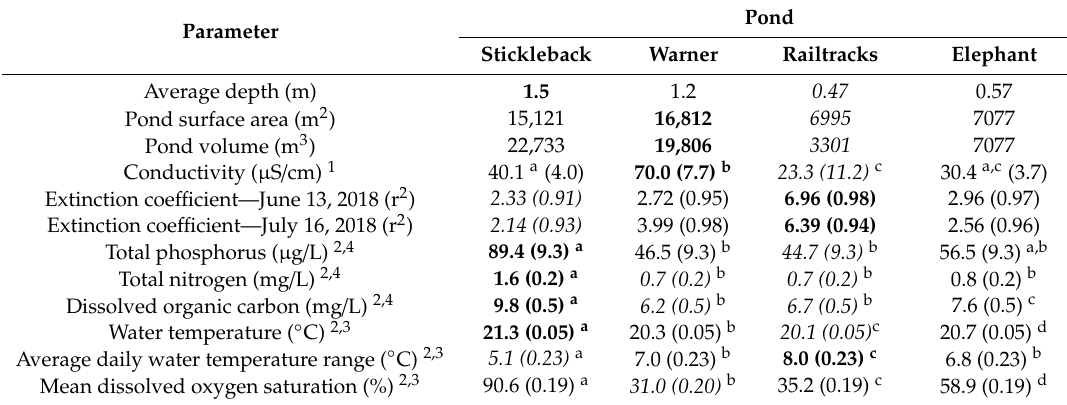
Figure 2. Depth profiles of temperature and dissolved oxygen for four ponds in east-central Minnesota, USA for two dates in 2018. Table 1. Values for various physical and chemical parameters for four ponds in east-central Minnesota. Within parameters, values with the same letter are not significantly di ff erent from one another (Tukey’s post hoc test). Cells labeled in bold show the pond with the maximum value of a parameter, while those in italics show the pond with the minimum